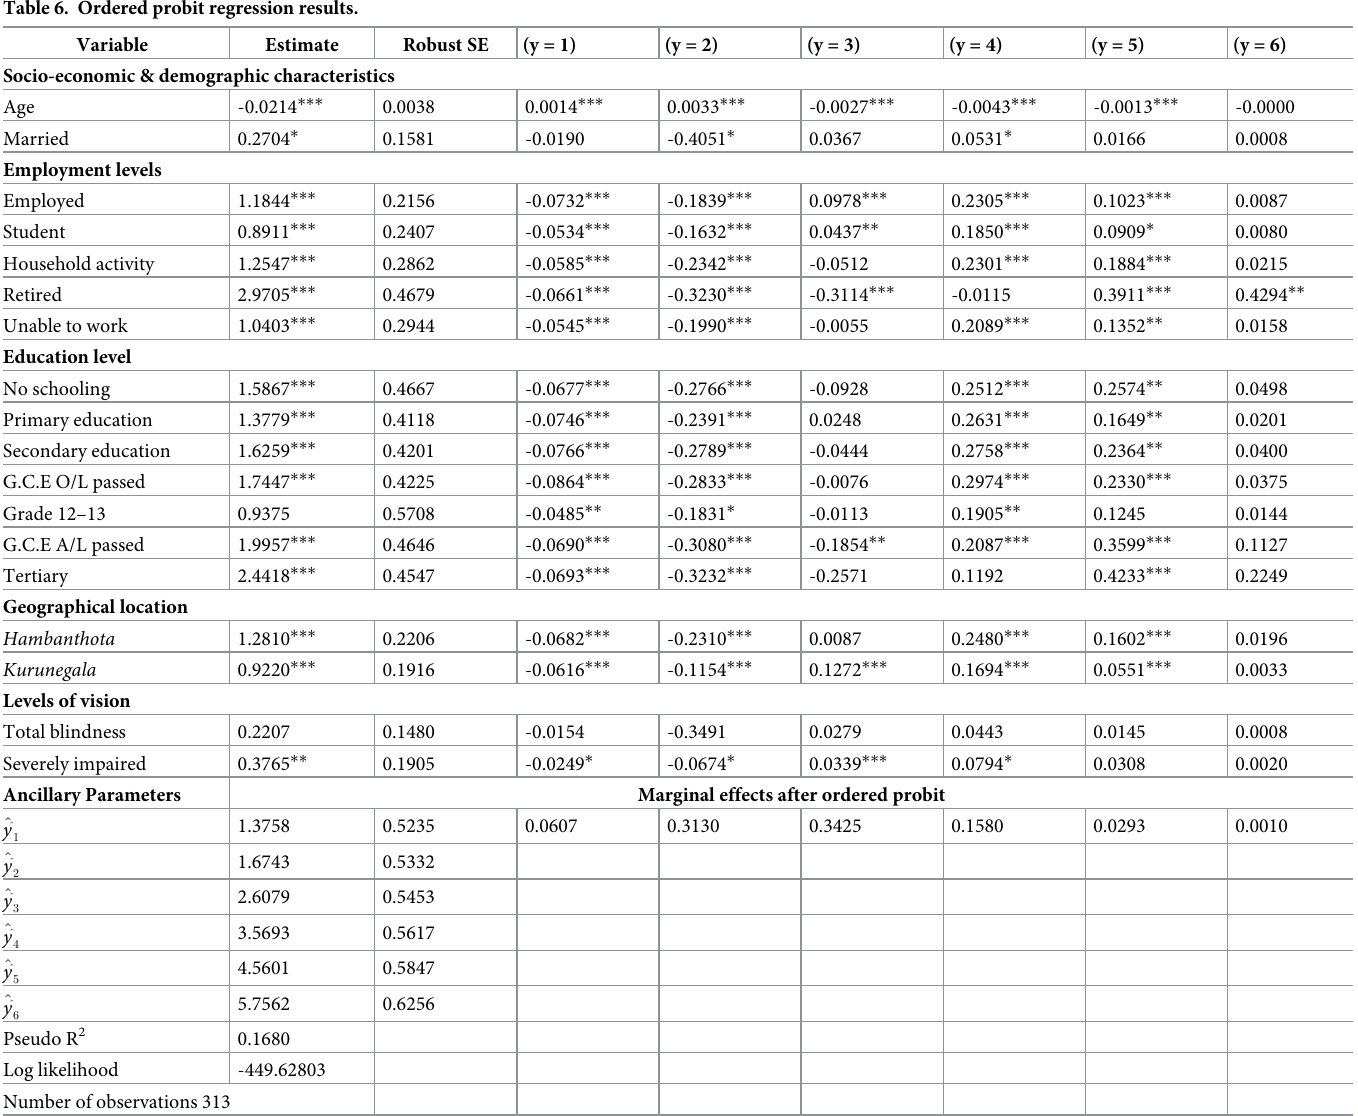
Table 6. Ordered probit regression